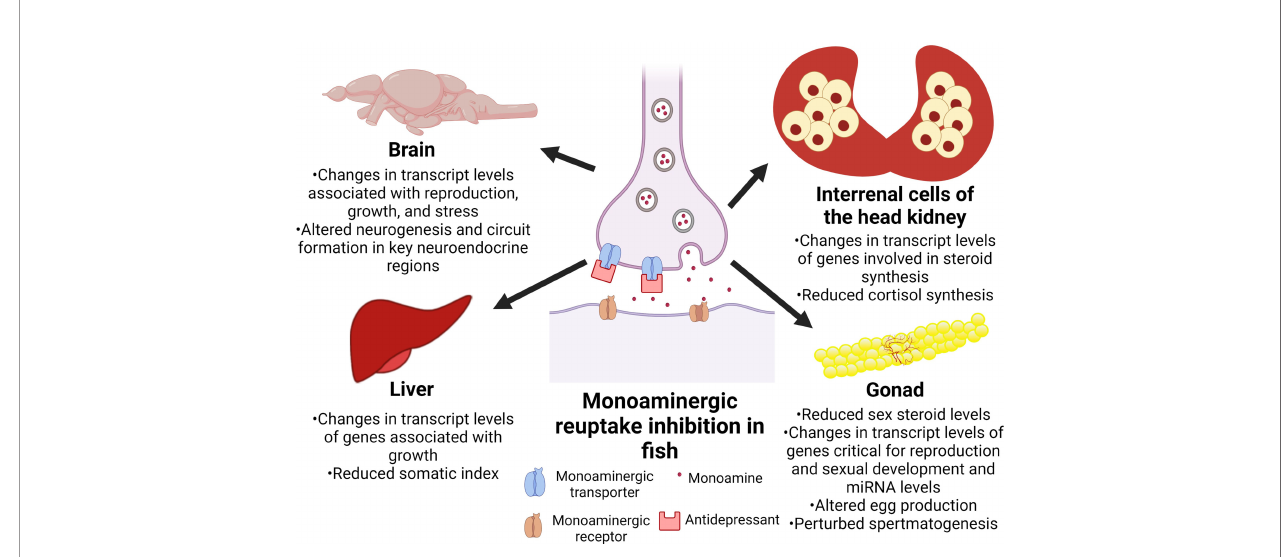
FIGURE 1 | Overview of the tissue-speci fi c impacts of antidepressants on the endocrine axes in fi sh. Depiction of the expected mode of action of antidepressants, along with the speci fi c tissues and the observed phenotypes associated with exposures to